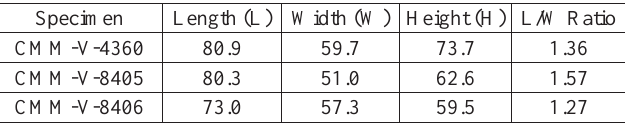
Table 1. Dimensions (in mm) of the odontocete peduncular vertebrae. Specimen